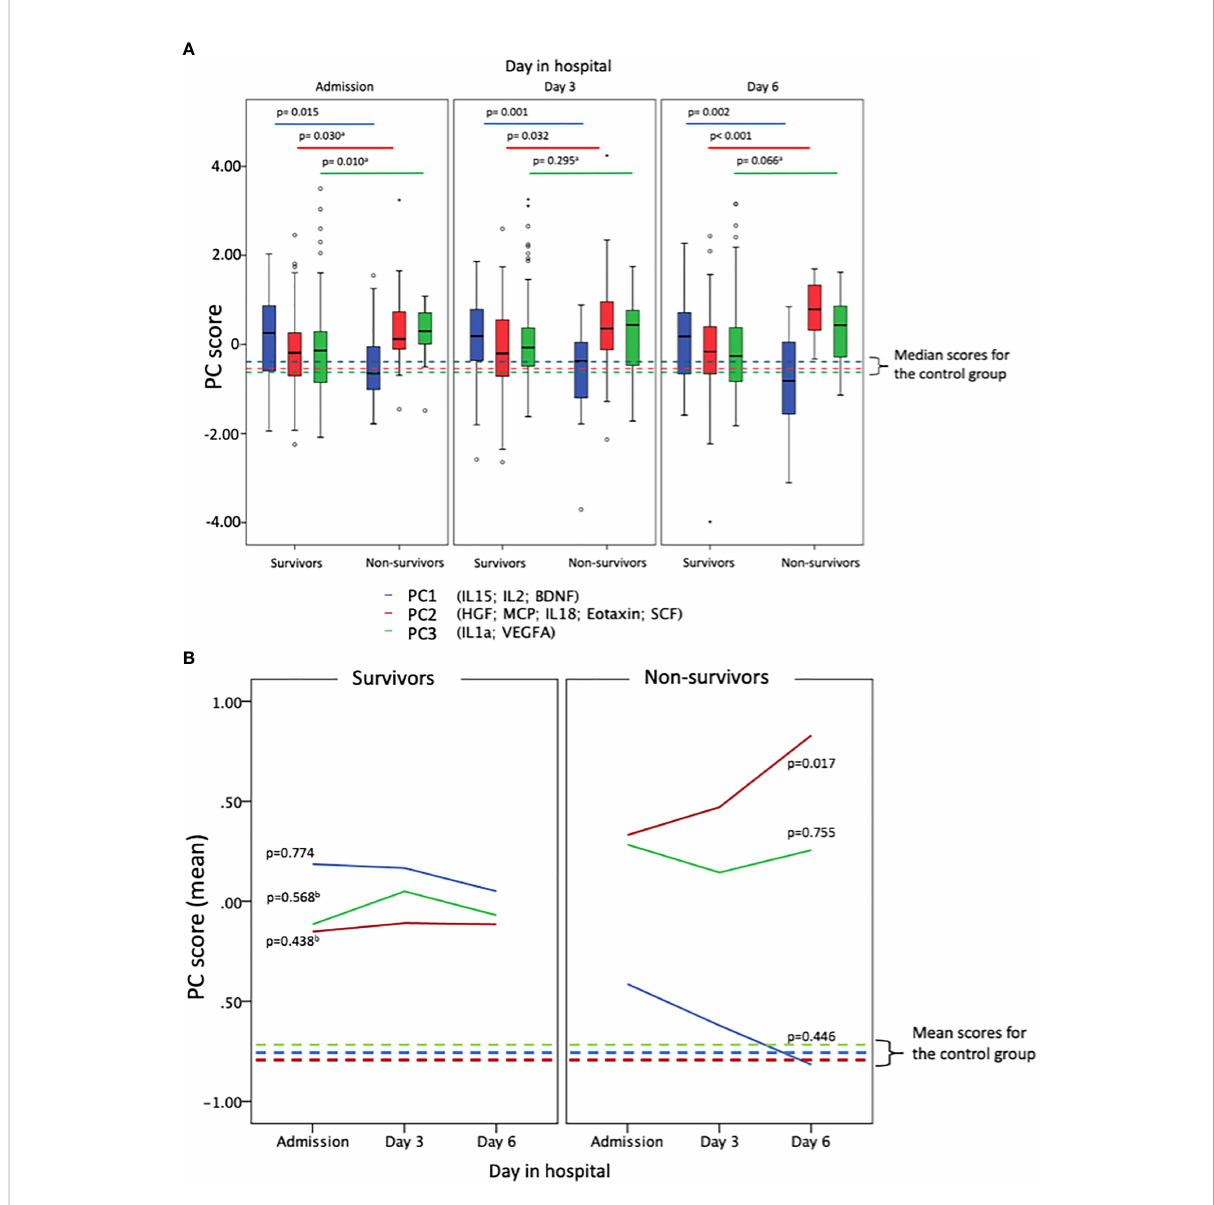
FIGURE 2 PC scores for COVID patients (survivors and non-survivors) and controls when applying PC estimators. In blue PC1 groups IL-15; IL-2 and BDNF. In red PC2 groups HGF; MCP1; IL-18; eotaxin and SCF. In green PC3 groups IL-1a and VEGFA. (A) Box-plots shows the different contribution of each of the factors obtained in the analysis of principal components for survivors and non-survivors, showing, in addition, three moments in the evolution of the disease ( fi rst, third and sixth days of admission of the patients). (B) Shows that in the fi rst 6 days of hospitalization, the mean score is stable and signi fi cantly lower for patients who survived than for those who died. In addition, a growing trend is observed for this marker in patients who did not survive. Trends over time of the PC scores for survivors and non-survivors were calculated separately by using RM- ANOVA or Friedman